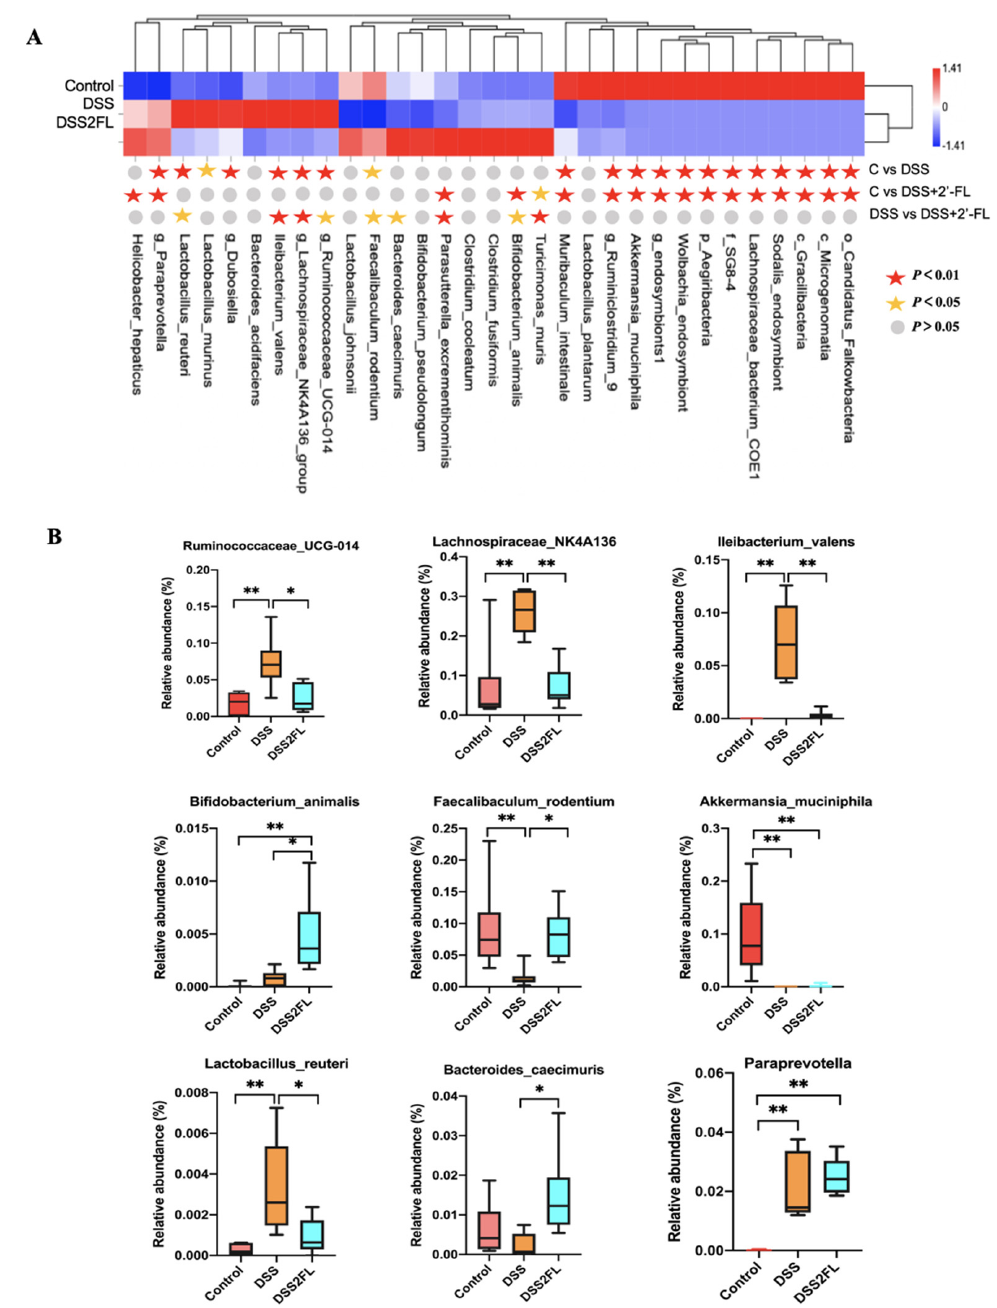
Figure 2. Strikingly differential species among the three groups. ( A ) The top 39 species across groups at the criteria of p -value < 0.05 by ANOVA rank sum test. The abundance profiles are transformed into Z scores by subtracting the average abundance and dividing the standard deviation of all samples. The Z score is negative (shown in blue) when the row abundance is lower than the mean. ( B ) The representative figures of significantly changed species across groups analyzed by one-way ANOVA test ( n = 6 for each group). *, p < 0.05. **, p < 0.01.